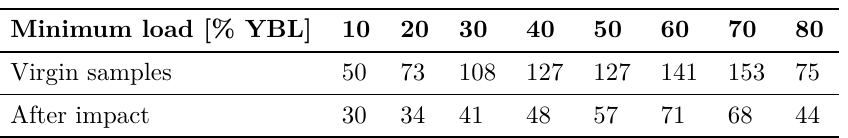
Table 1. Number of cycles up to fatigue rupture.